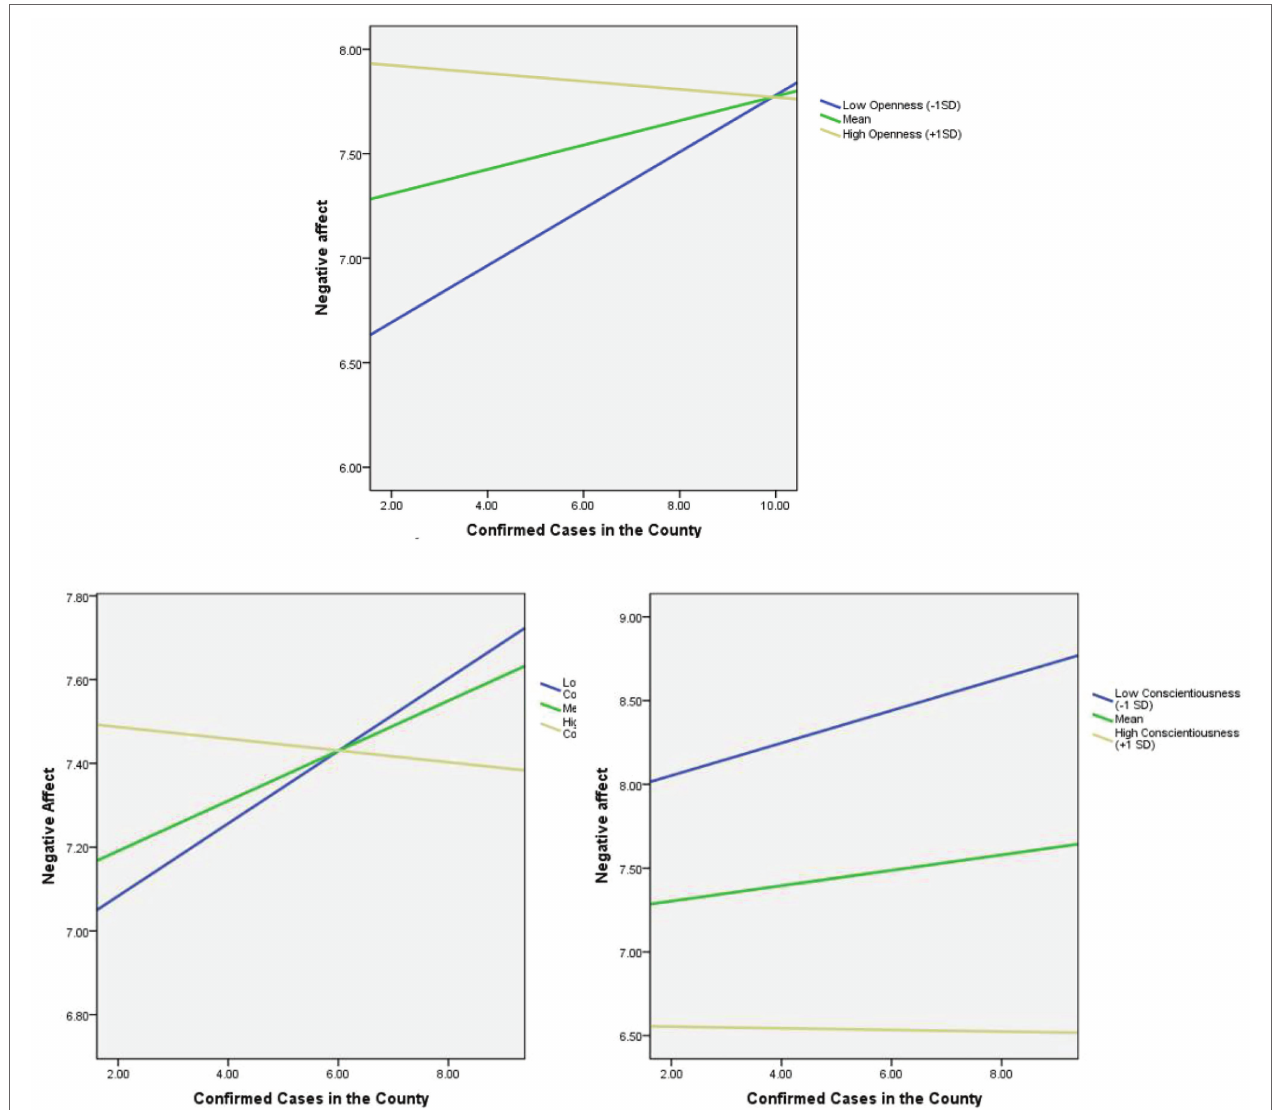
FIGURE 4 | Moderating effect of openness, conscientiousness, and family connectedness on the relationship between confirmed cases and negative affect. Note. X -axis: confirmed cases in 1,000 s. Y -axis: range between 0 and